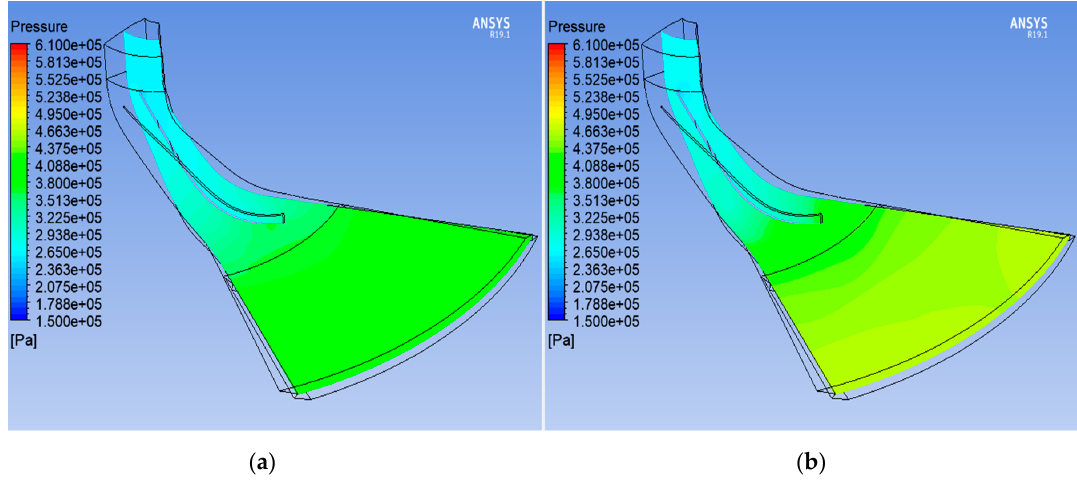
Figure 8. Pressure Contour for R134a at an RPM of 35,000 ( a ) and 40,000 ( b ).